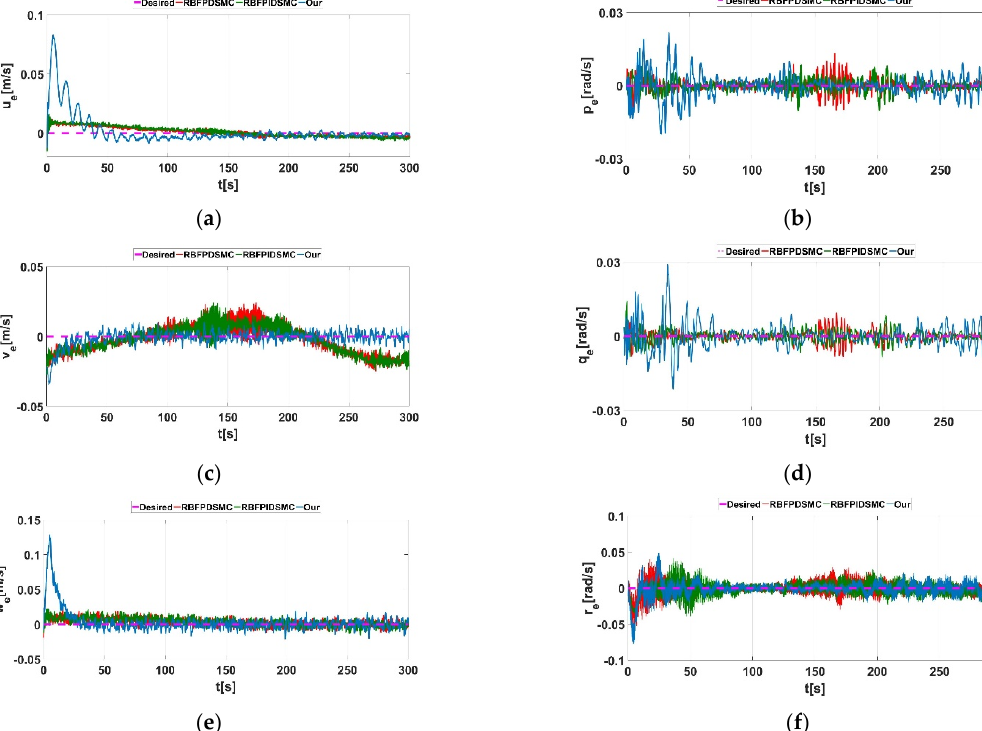
Figure 13. AUV velocity − tracking errors. ( a ) u e ; ( b ) p e ; ( c ) v e ; ( d ) q e ; ( e ) w e ; ( f ) r e Table 4. Average values of 𝐷 𝐸 .